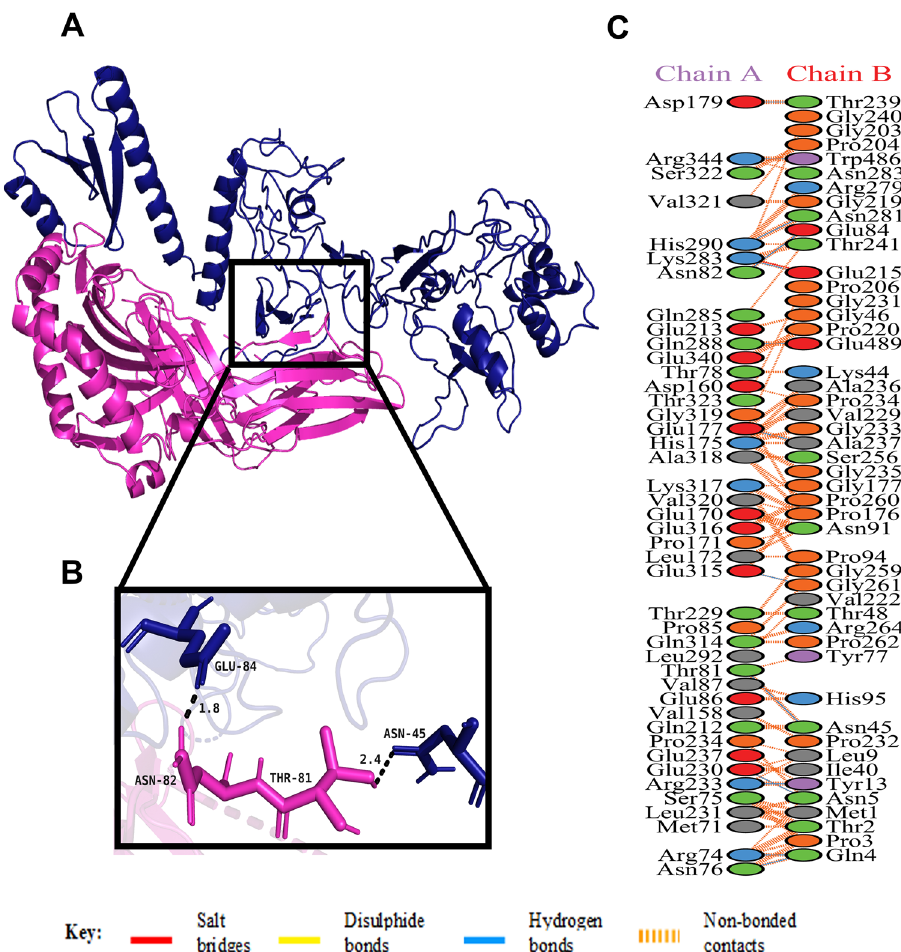
Figure 8. ( A ) Figure acquired after molecular docking which shows docked MHC class II receptor-vaccine complex. The vaccine construct is shown in deep blue while the MHC class II receptor is shown in purple. ( B ) Residue interaction between the docked MHC class II receptor (chain A) and the vaccine (chain B). ( C ) Few hydrogen bonds shown within vaccine-MHC class II receptor complex are focused.